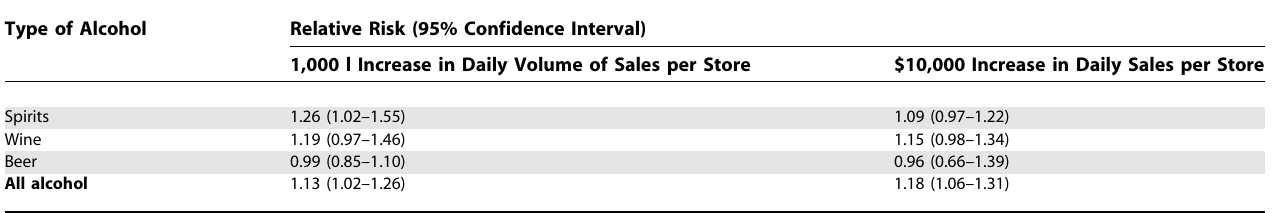
Table 2. Risk of Assault-Related Hospitalization in Association with Daily Alcohol Sales among 3,212 Cases of Assault Type of